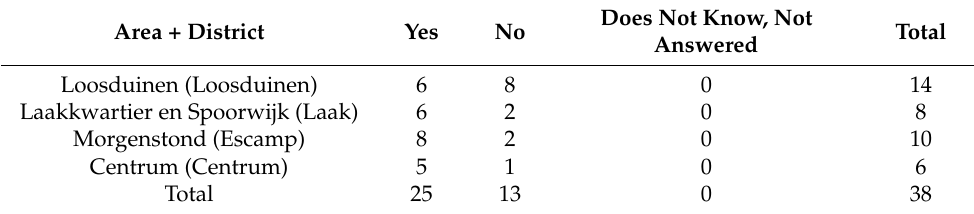
Table 3. Answers to the question: Do you ever feel